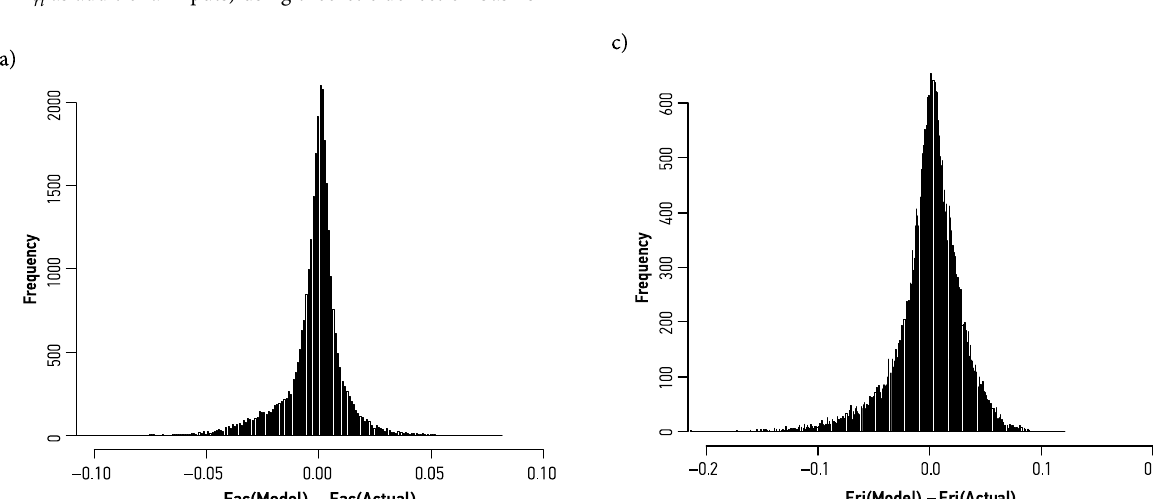
Fig. 7. Summary of base layer moduli ( K b ) prediction performance with data mining techniques (including E ac and E ri as additional inputs) using theoretic deflection basins